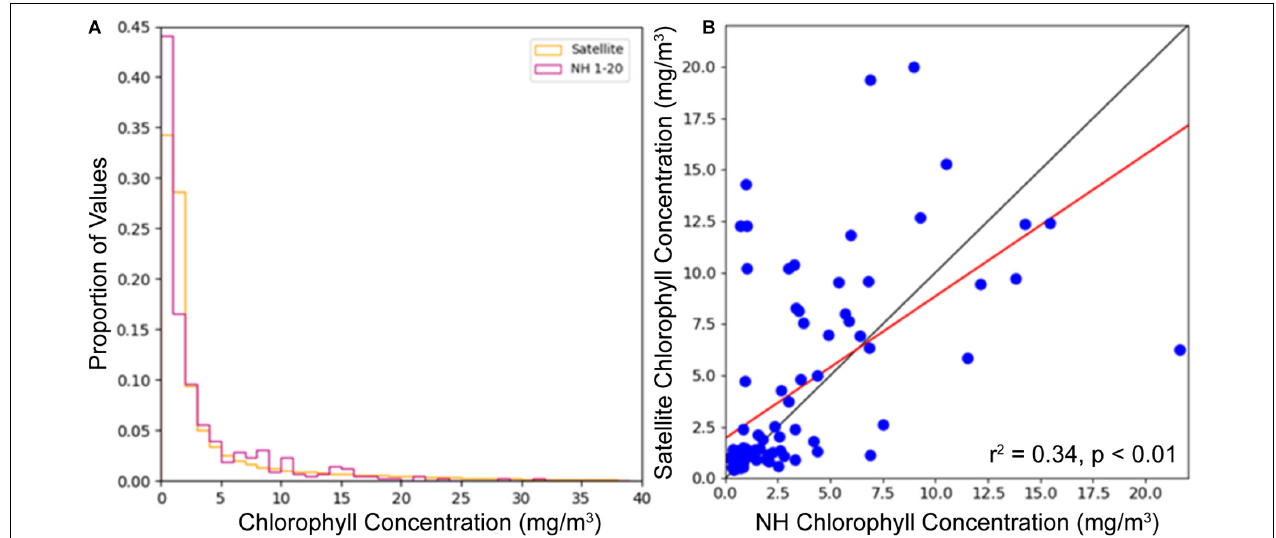
FIGURE 4 | Comparison of GlobColour merged satellite product with in situ measurements taken along the Newport Hydrographic Line (NH) January 2013 through February 2018. Proportion of values histogram, where satellite values are 8-day composites over a 1 ◦ latitude band centered on 44.6 ◦ N while NH values are individual measurements for each station on each sample date ( A ). Scatter plot comparing the mean of NH stations sampled on each date with the mean of the satellite field for the Newport region for the corresponding 8-day composite ( B ), where the red line represents the trendline for the data, with an r 2 = 0.34, p < 0.01, while the diagonal gray line is 1:1.